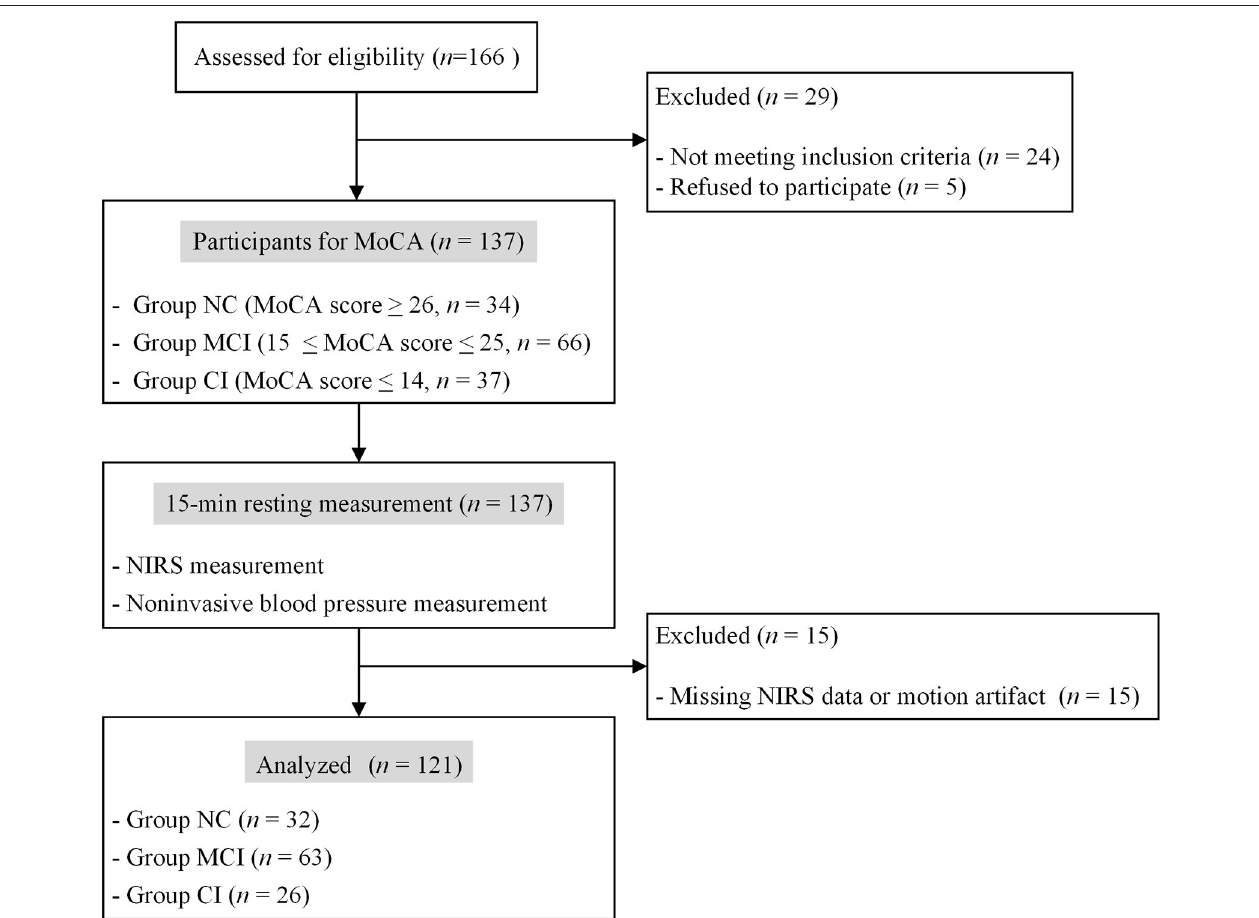
FIGURE 1 | Flow chart of participant